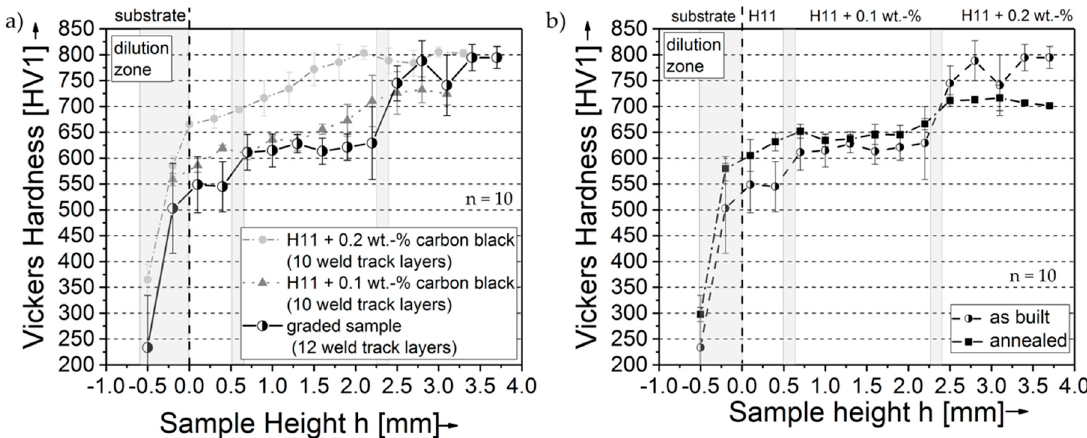
Figure 17. ( a ) Hardness distribution of the graded sample and of samples manufactured with 0.1 wt. % and 0.2 wt. % additional carbon black nanoparticles, ( b ) Hardness distribution of the graded sample in the as-built state and after annealing.